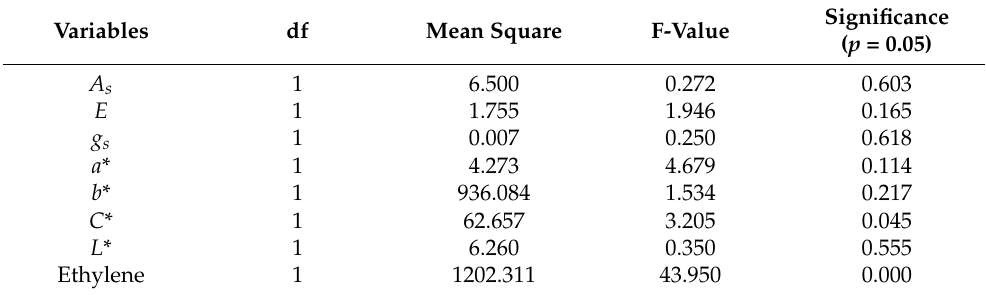
Table 1. ANOVA outcomes of net CO 2 assimilation ( A s ; µ mol m − 2 . s), transpiration ( E ; mmol m − 2 .